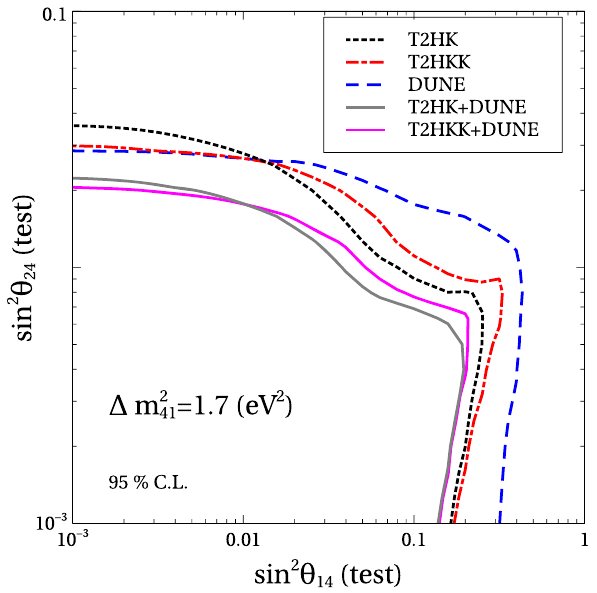
Fig. 8 The expected 95% C.L exclusion curves in the sin 2 θ 14 (test)- sin 2 θ 24 (test) plane for a fixed (cid:5) m 2 same as Fig.